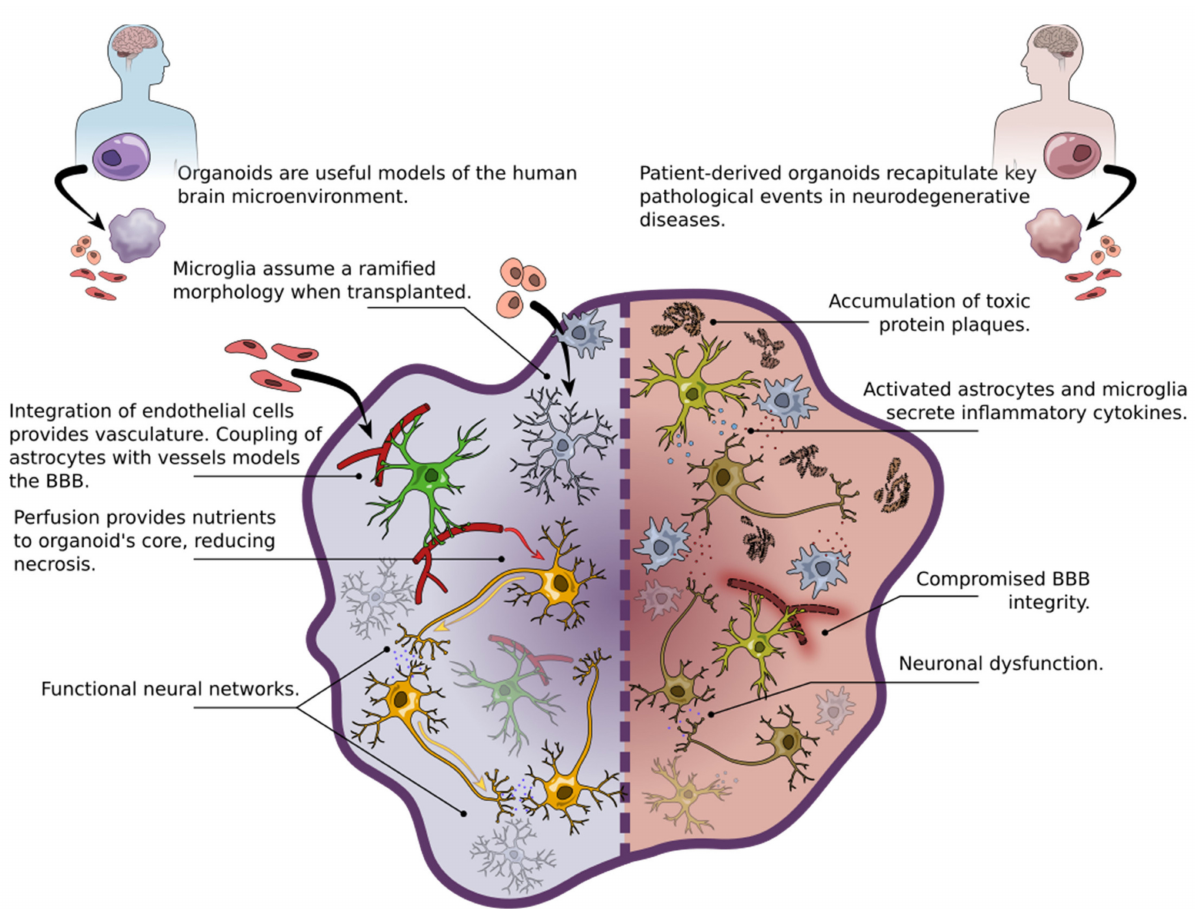
Figure 3. Left side: iPSC-derived brain organoids from a healthy human subject can be used to specifically model the brain microenvironment, including studying interactions between a variety of cell types. Additionally, modifications such as integration of microglia and endothelial cells provides opportunities to further elucidate functions of these cells in vitro. Right side: Using brain organoids derived from the cells of a human patient is a powerful tool to study disease mechanisms. Typical features of neurodegenerative diseases can be modelled in brain organoids, namely plaque formation, glia activation, and neuronal dysfunction. BBB=blood–brain